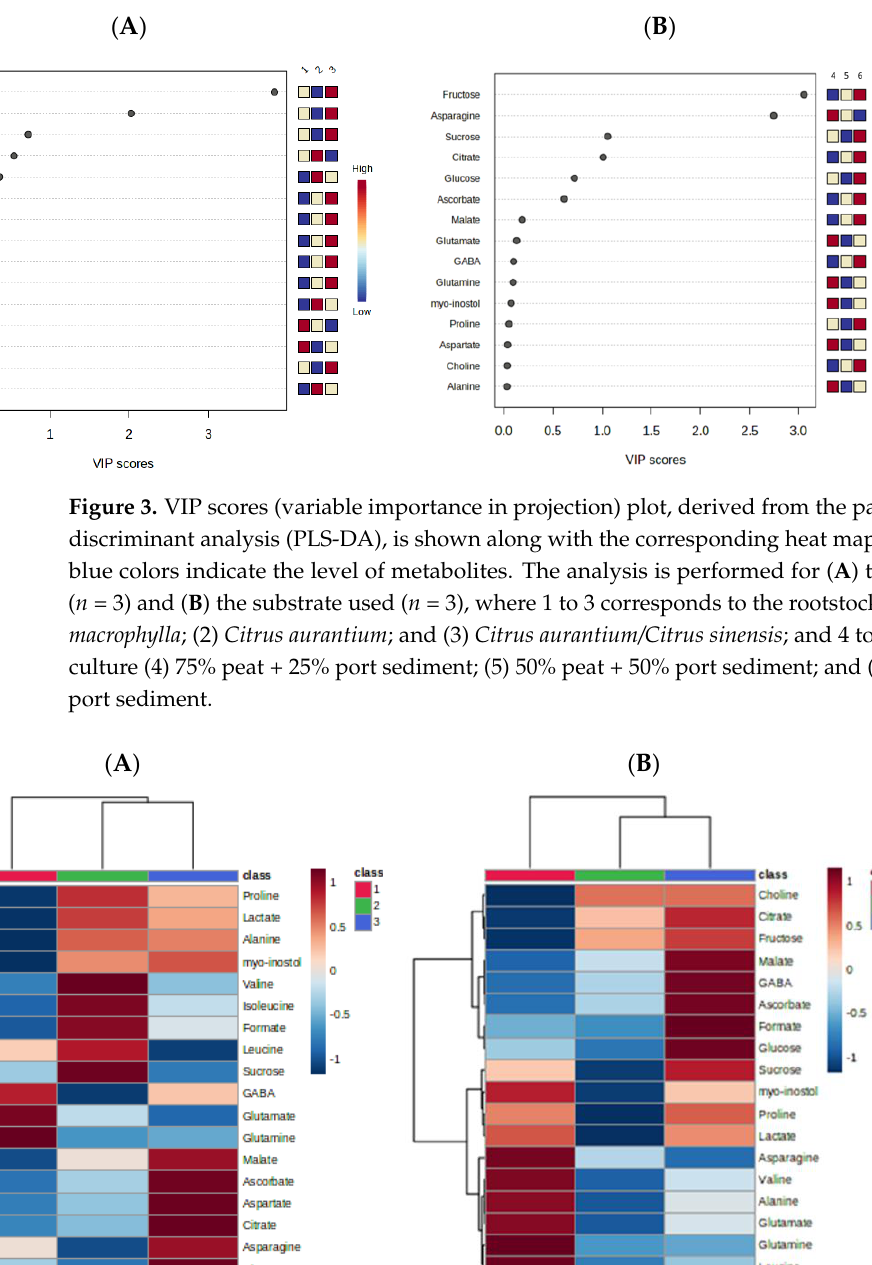
Figure 4. Visual representation of the metabolomic study of lemon peel grown in 9 different treatments (3 rootstocks × 3 substrates) using hierarchical clustering heatmaps. The heatmaps are analyzed based on ( A ) the rootstock used ( n = 3) and ( B ) the substrate ( n = 3), where 1 to 3 corresponds to the rootstock type as (1) Citrus macrophylla ; (2) Citrus aurantium ; and (3) Citrus aurantium/Citrus sinensis ; and 4 to 6 is related to the culture media: (4) 75% peat + 25% port sediment; (5) 50% peat + 50% port sediment; and (6) 25% peat + 75% port